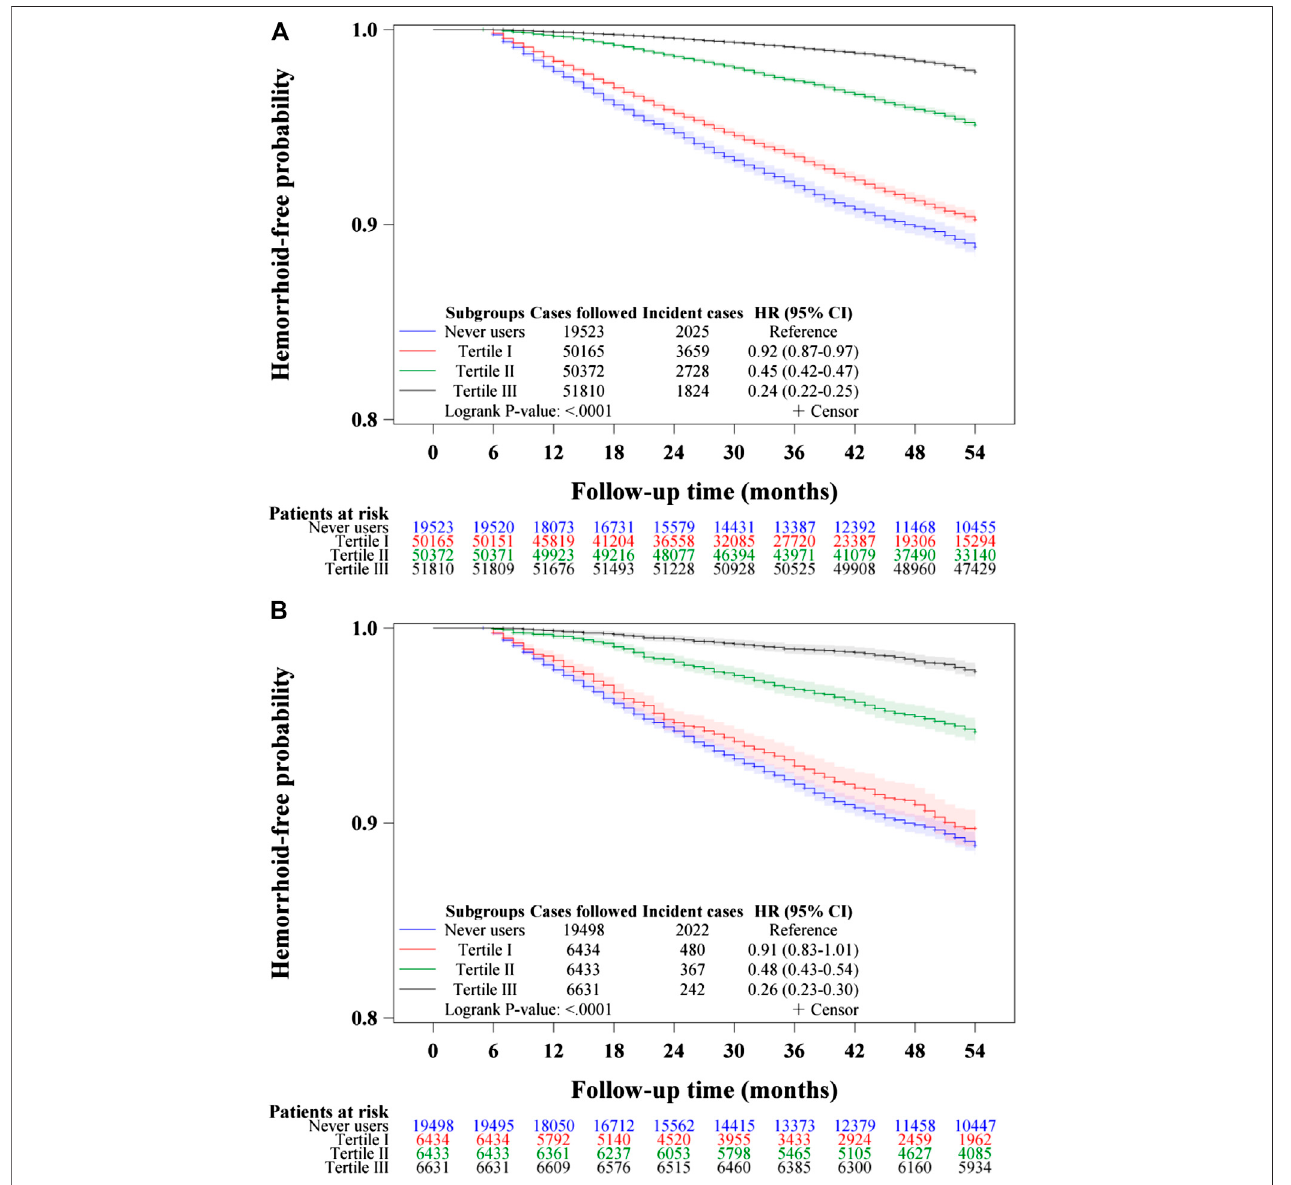
FIGURE4| Kaplan – Meiercurvescomparinghemorrhoid-freeprobabilityamongneverusersandtertilesofcumulativedoseofmetformintherapyintheunmatched cohort (A) and the matched cohort (B) , respectively.